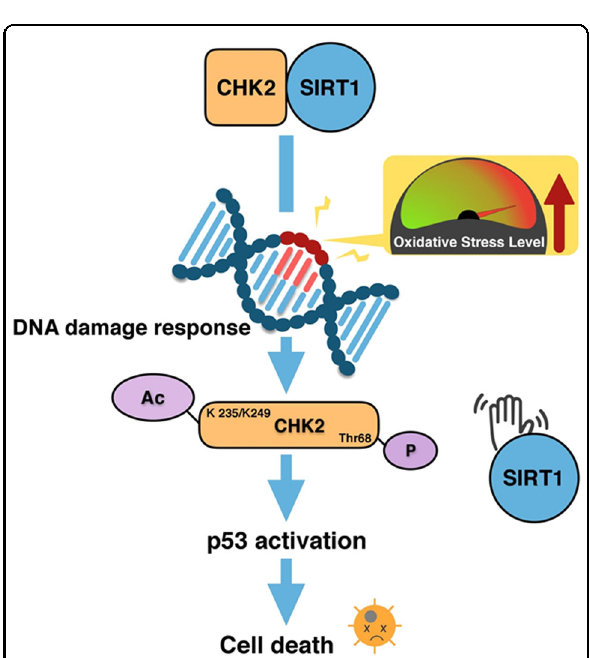
Fig. 5 Suggested model. Under normal conditions, SIRT1 binds to CHK2 and inhibits its activity through deacetylation. Oxidative stress initiates DDR pathways, which leads to dissociation of SIRT1 from CHK2, and this in turn increases the acetylation and the activity of CHK2. The phosphorylation and acetylation of CHK2 potentiates p53 activity, which results in cell death upon oxidative